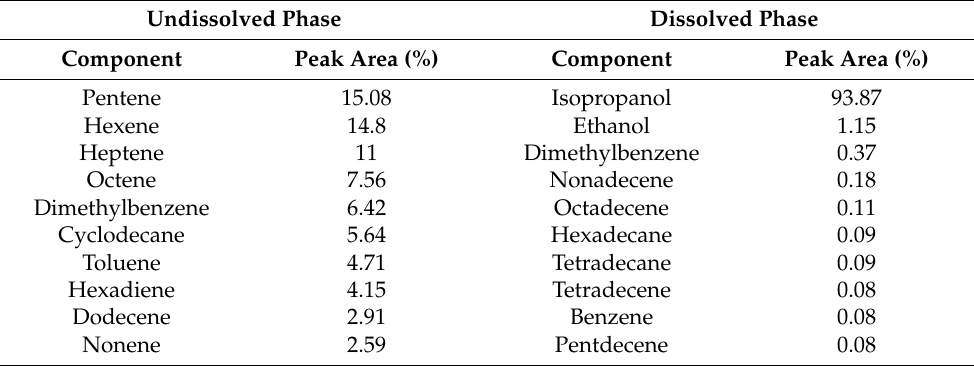
A natural clay catalyst doped with Ni was employed in a secondary reactor to reduce the yield of tar and wax in the produced gas. The clay containing mainly SiO 2 and some amount of Al 2 O 3 , Fe 2 O 3 , CaCO 3 , MgCO 3 , etc. [31] had the initial specific surface area of approximately 100 m 2 g − 1 ; however, its surface area decreased by calcination to 35 m 2 g − 1 . Details of the two-stage RDF gasification with a clay catalyst in the secondary reactor were published in a previous work [22]. Here, we focus on the effect of the secondary catalyst on the tar and wax yield only. Figure 5 shows tar fraction captured in isopropanol after the secondary catalytic stage. A comparison of this picture with Figure 2 shows a significant visible effect of secondary catalysis on the tar and wax yield. After installing the catalytic stage, no solid fraction was captured in isopropanol and the used isopropanol had a clearer color.